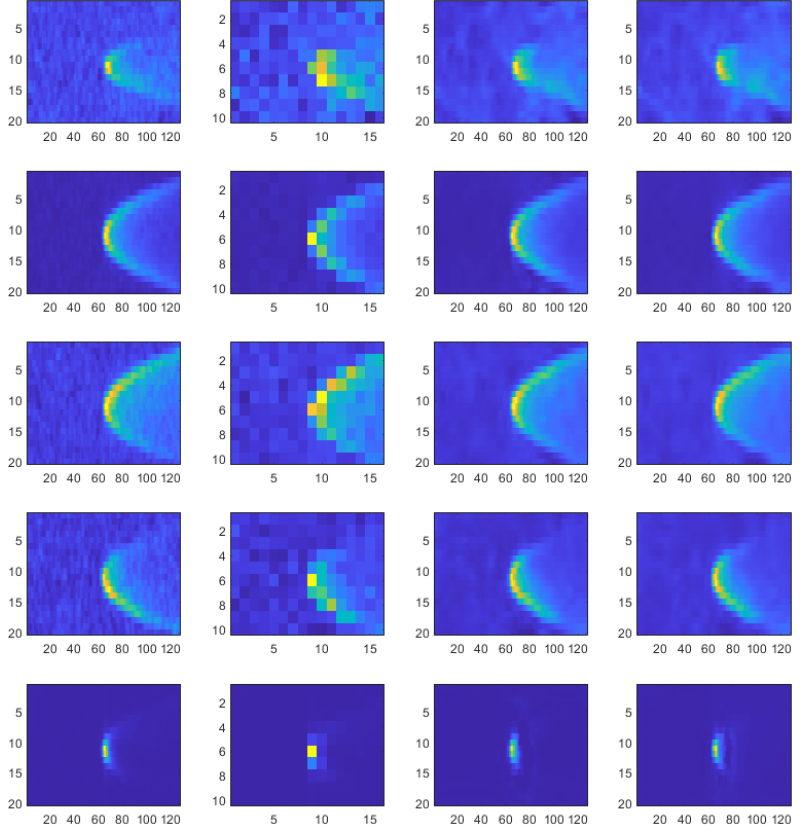
Figure 8. Examples of the DDM comparison of the FR-DDM, LR-DDM, and SR-DDM. The first and second columns are the FR-DDM and LR-DDM, respectively. The third and fourth columns are the SR-DDMs reconstructed by the VDSR in scheme 1 and scheme 2, respectively. The first row is the case of the lowest DDM signal-to-noise ratio (SNR) in the test set, and the fifth row is the case of the highest DDM SNR in the test set. The middle three rows are randomly selected cases. Remote Sens. 2020 , 12 , 916